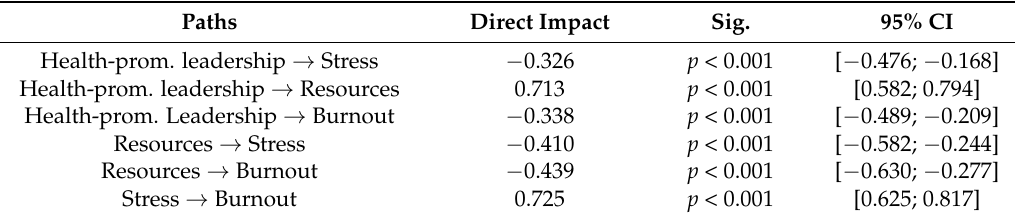
Table 7. Total impacts in the structural model—sample